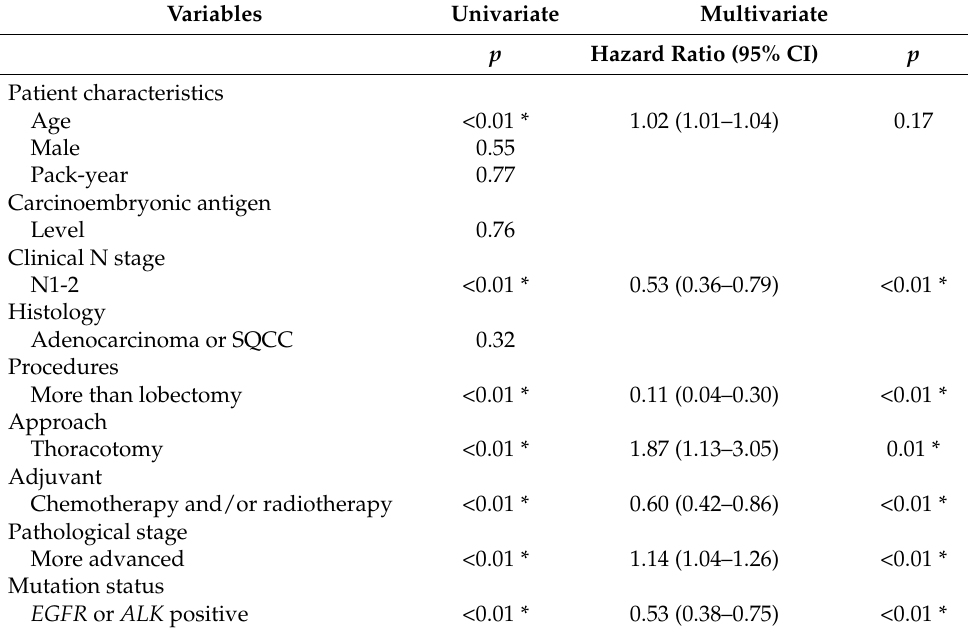
Table 3. Univariate and multivariate analyses for systemic lymph node dissection.